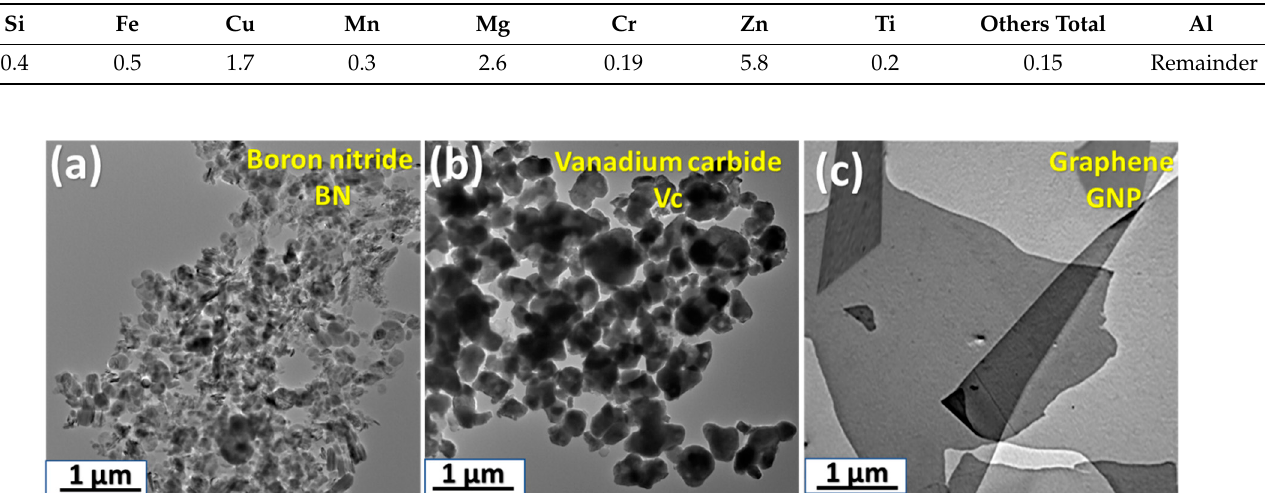
Table 1. Chemical composition of AA 7075 wrought alloy (wt%).